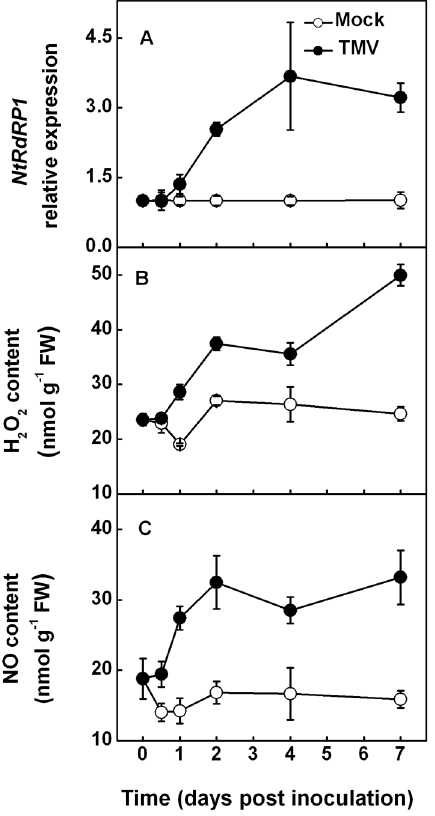
Figure 1. Time course changes of NtRDR1 transcripts and concentrations of H 2 O 2 and NO. Changes in the transcript levels of Nicotiana tabacum RNA-dependent RNA Polymerase 1 ( NtRDR1 , A ), hydrogen peroxide (H 2 O 2 , B ), and nitric oxide (NO, C ) over time in the non-inoculated upper leaves of Nicotiana tabacum plants after TMV inoculation of the lower leaves. The results are expressed as the mean 6 SD, n = 4.